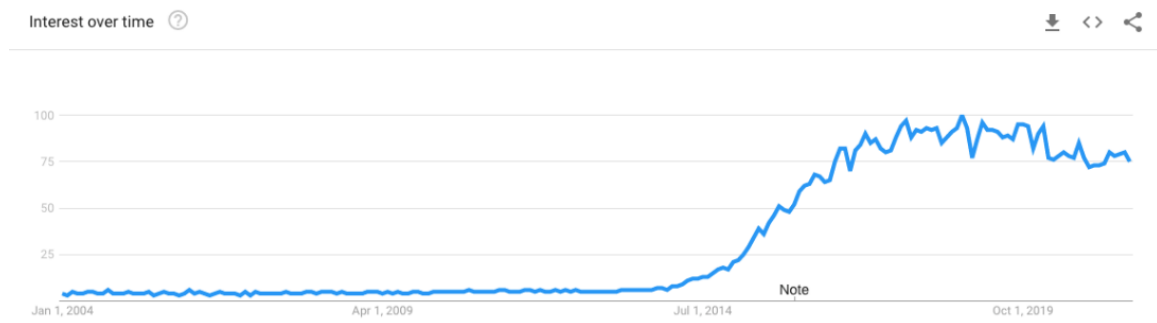
Figure 3. Distribution of the articles reviewed in the study by year.